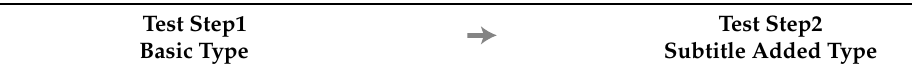
Table 2. Experiment design for news.